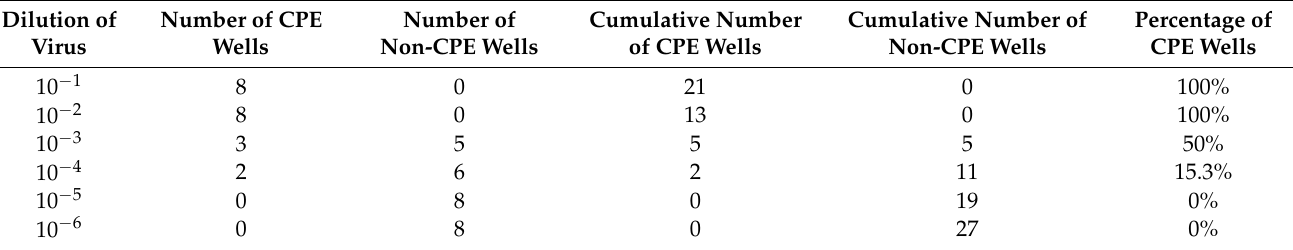
Table 2. The infectivity of influenza A virus on MDCK cells.